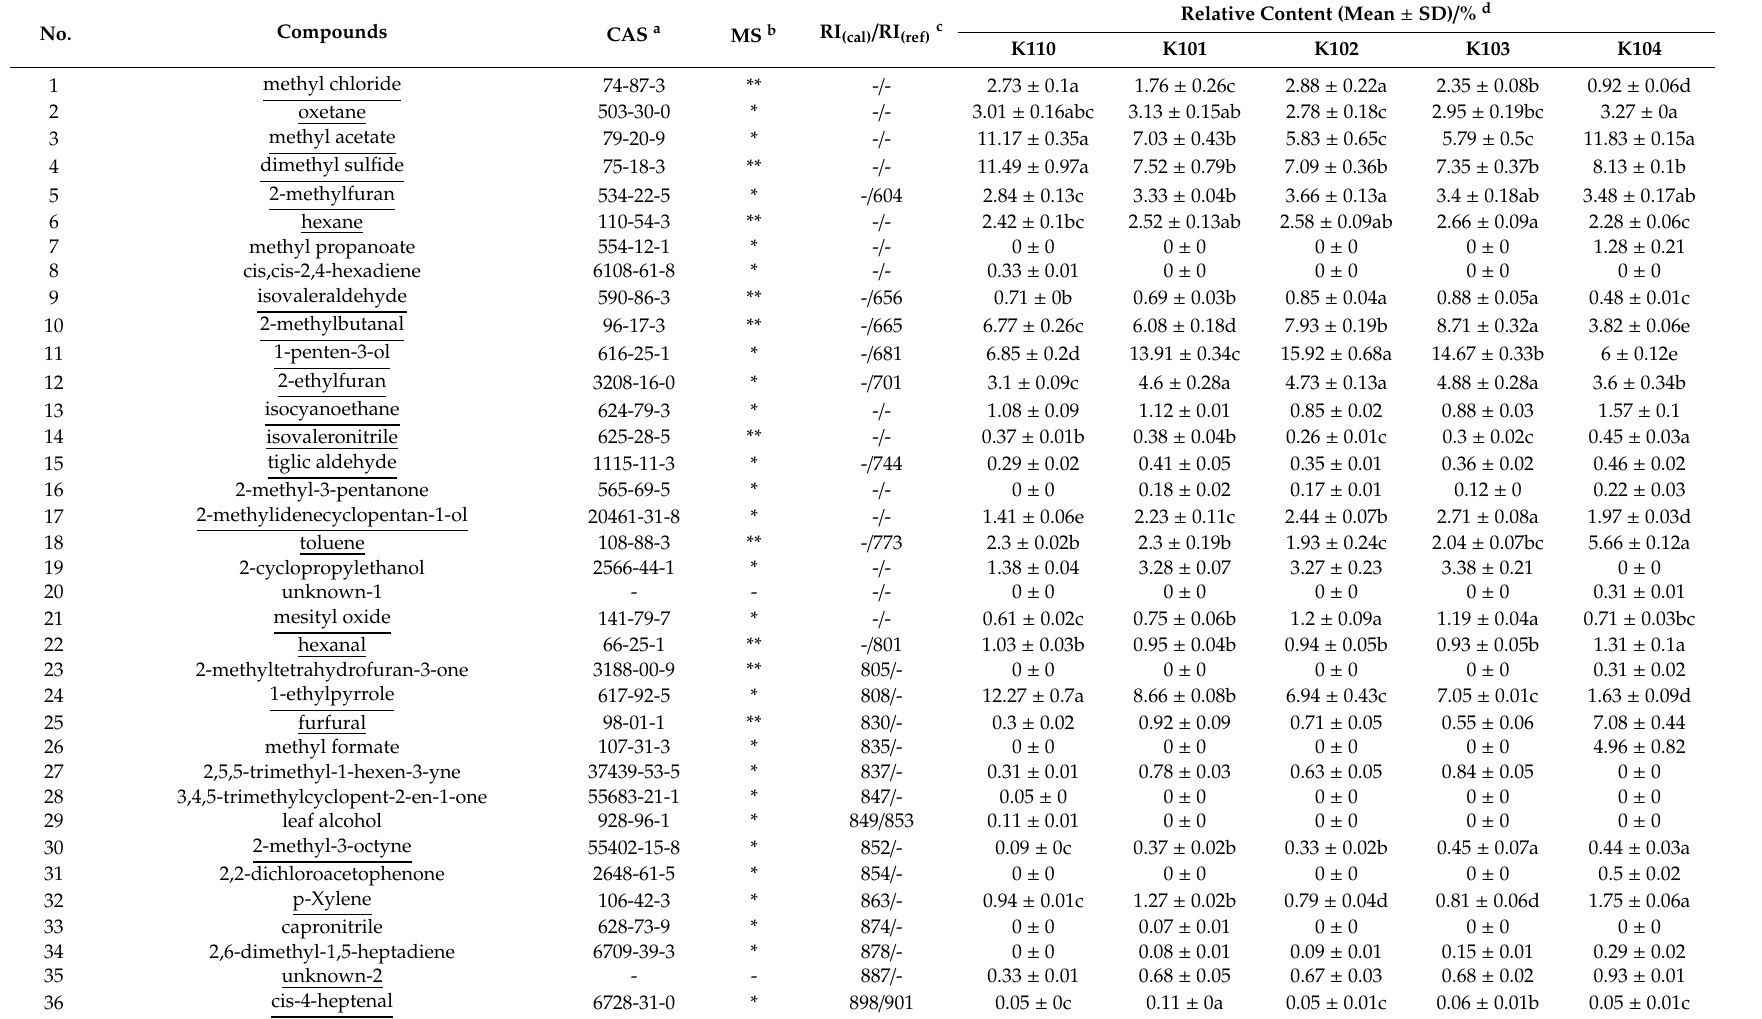
Table 1. The qualitative and quantitative results of five grades tea